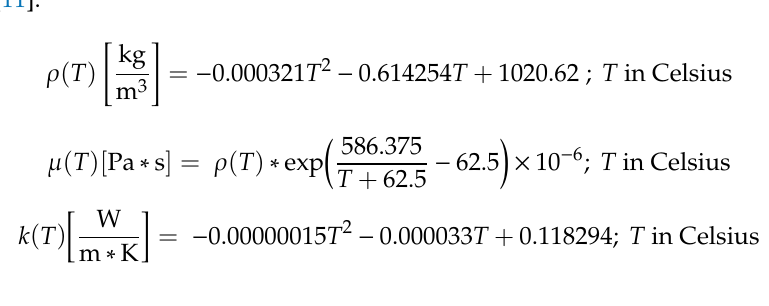
Figure 5. Fluid and filler temperature at the axial locations of i = 1 (top of the tank), i = 50 (25% down the tank), i = 100 (50% down the tank), i = 150 (75% down the tank), and i = 200 (bottom of the tank).